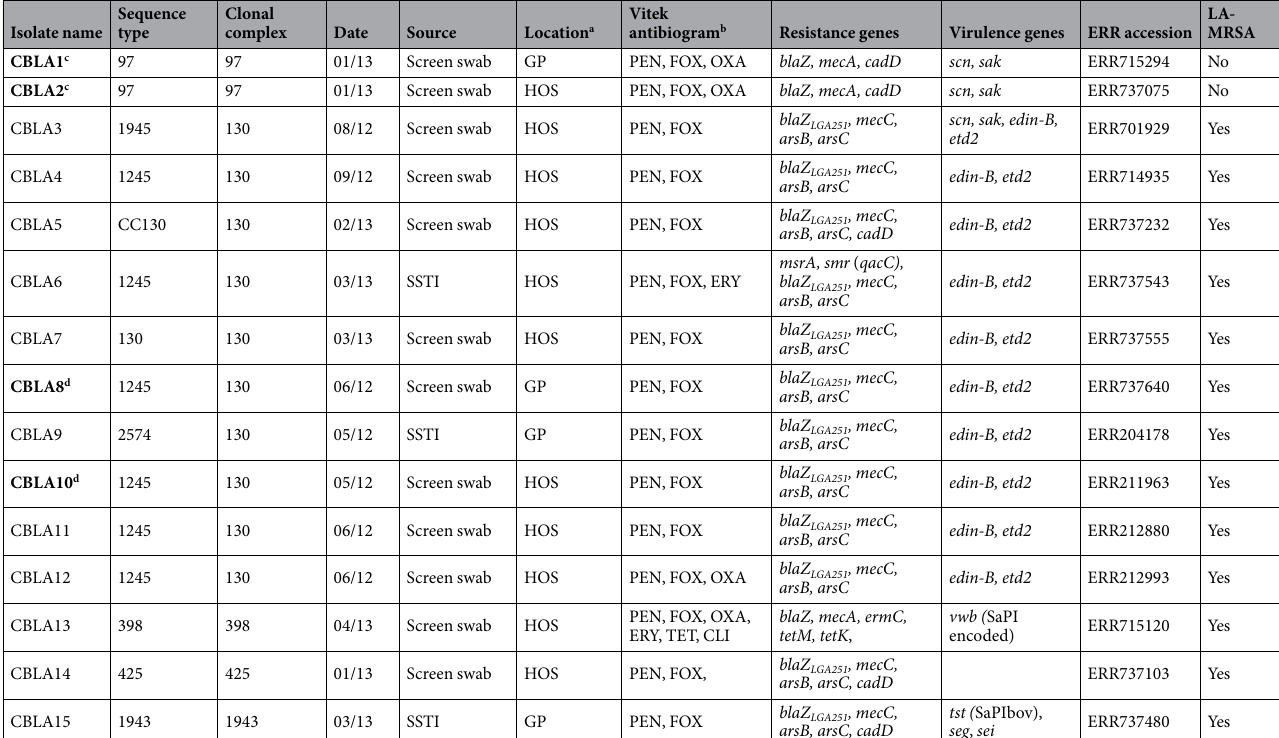
Table 1. Potential Livestock associated MRSA strains and associated data. a Location: HOS = Hospital, GP = General practitioner. b Vitek antibiogram: Three letter codes indicate resistance to : PEN = Benzlpenicillin, FOX = Cefoxitin, OXA = Oxacillin, FUS = Fusidic acid, ERY = Erythromycin, TET = Tetracycline, CLI = Clindamycin. Bold text - c denotes that CBLA1 and CBLA2 were isolated from the same patient. d